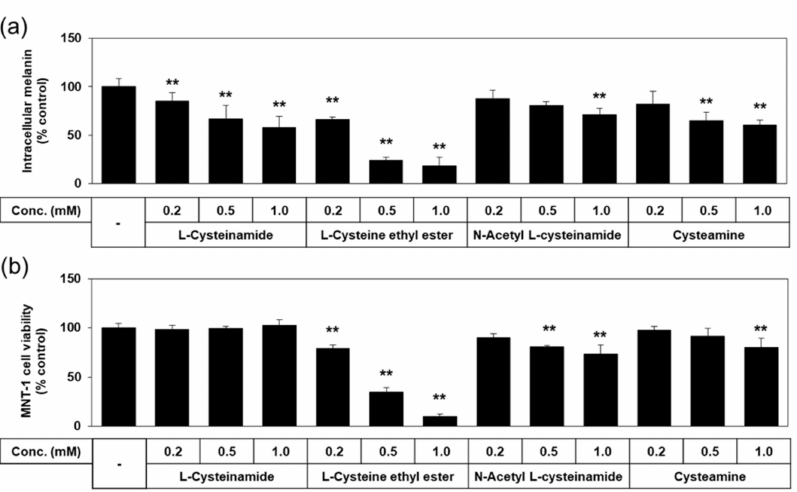
Figure 5. Effects of L-cysteinamide, L-cysteine ethyl ester, N-acetyl L-cysteinamide, and cysteamine on the melanin content and viability of MNT-1 cells. Cells were treated with vehicle (control) or each substance at the indicated concentrations for 72 h. Melanin content ( a ) and cell viability ( b ) are presented as % of control (means ± SD, n = 3). ** p < 0.01 vs.